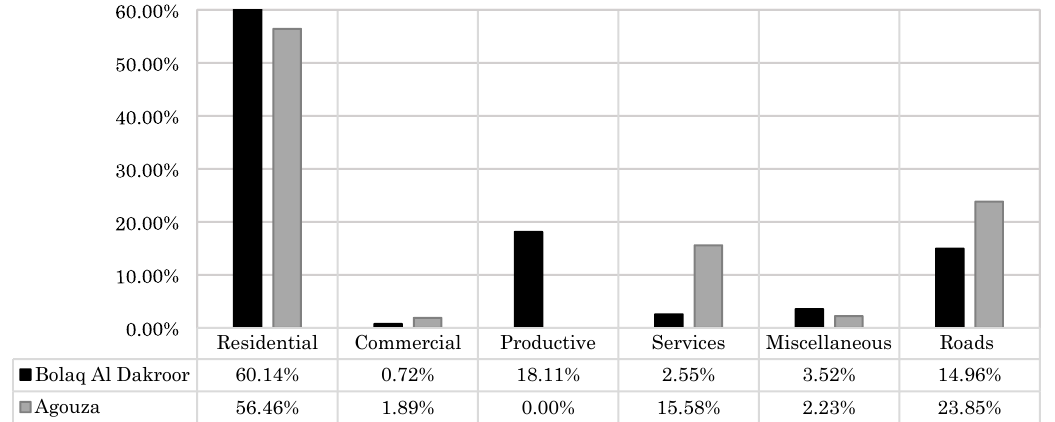
Figure 3. Shows the percentage of land-use in both of study samples.